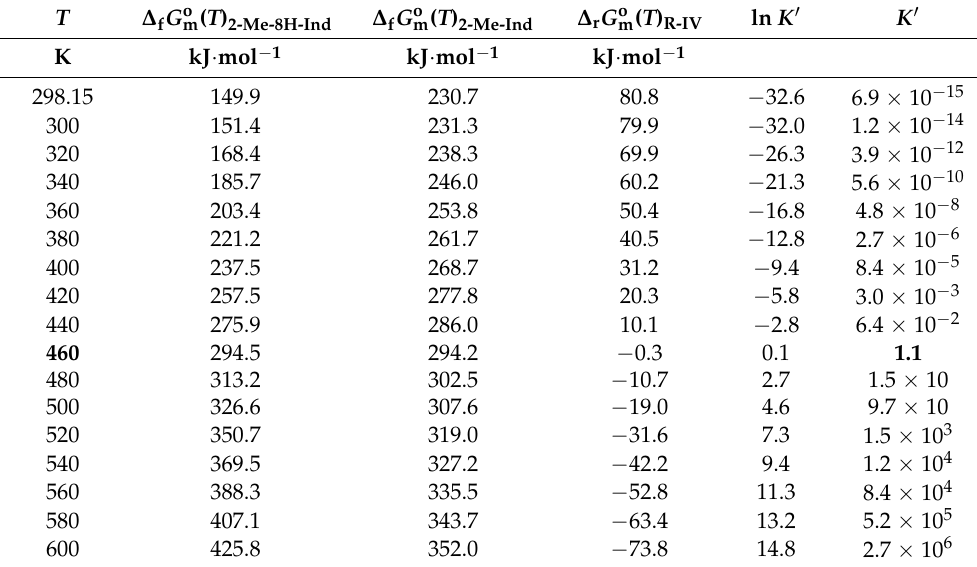
Table 13. Gas-phase standard molar Gibbs energies of 2-methyl-8H-indole and 2-methyl-indole and thermodynamic parameters of the dehydrogenation reaction R-IV at p ◦ = 0.1 MPa a .